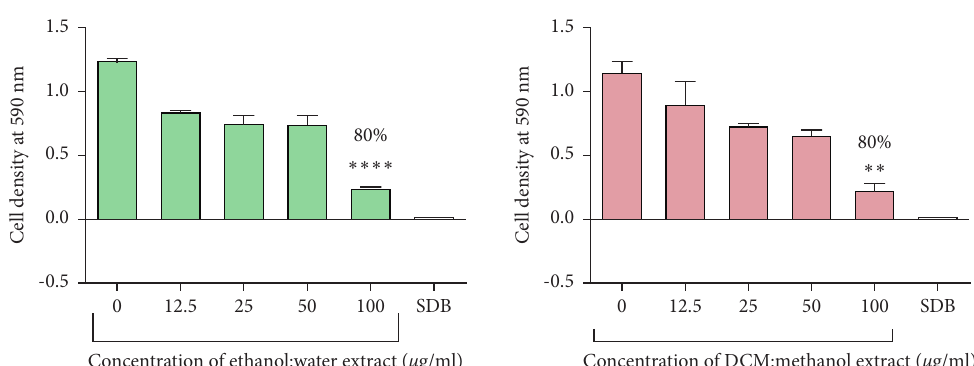
Figure 5: The effect extracts from C. citrinus on C. albicans . The graph shows a dose-dependent decrease in C. albicans cell density as the concentration of the ethanol: water extract and the DCM: methanol increased. Percentage inhibition of 80% was observed at 100 μ g/ml. The data represent a mean of four replicates. These data were analysed using one-way ANOVA followed by Dunnett’s test for multiple comparisons, comparing means to the negative control (SDB). Error bars indicate standard deviation; ∗∗∗∗ p < 0 .